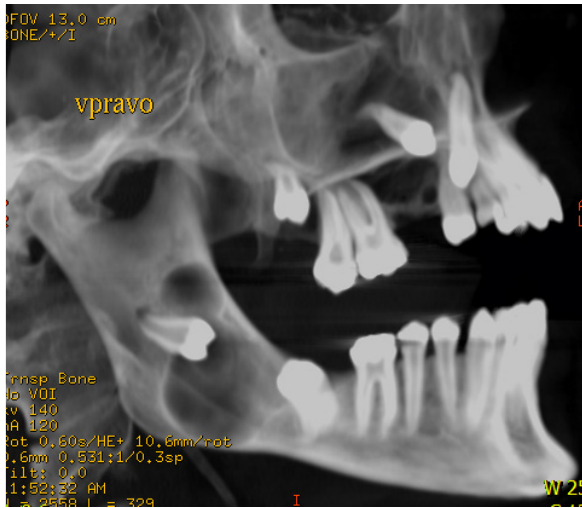
Fig. 4. Multiple syndromic keratocysts associated with retained